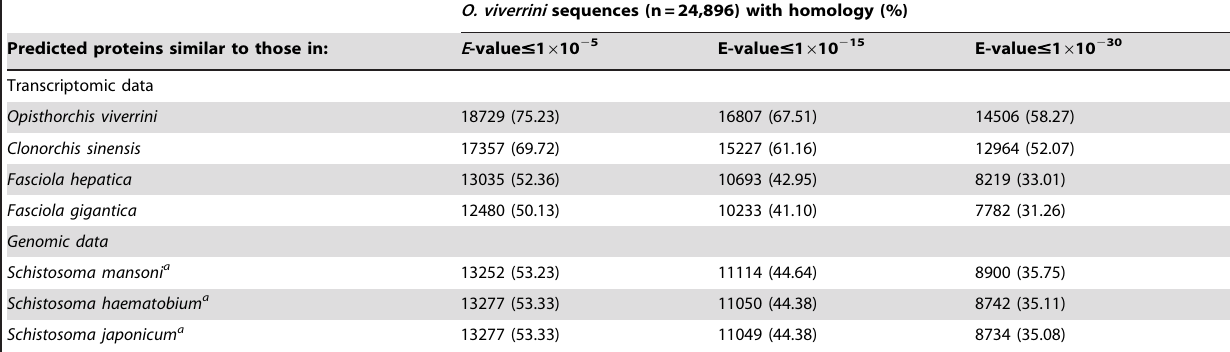
O.viverrini sequences (n=24,896) with homology (%)